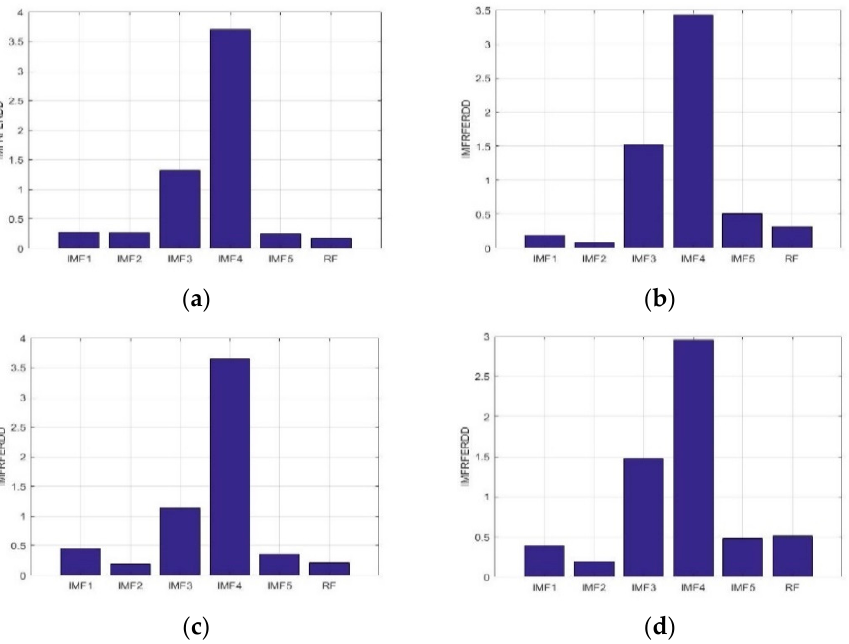
Figure 5. Average IMFRFERDD values of the IMF1-IMF5, and RF to the F5AM, F5MI, F6AM, and F6MI, respectively. ( a ) Average IMFRFERDD values (F5AM), ( b ) average IMFRFERDD values (F5MI), ( c ) average IMFRFERDD values (F6AM), and ( d ) average IMFRFERDD values (F6MI).